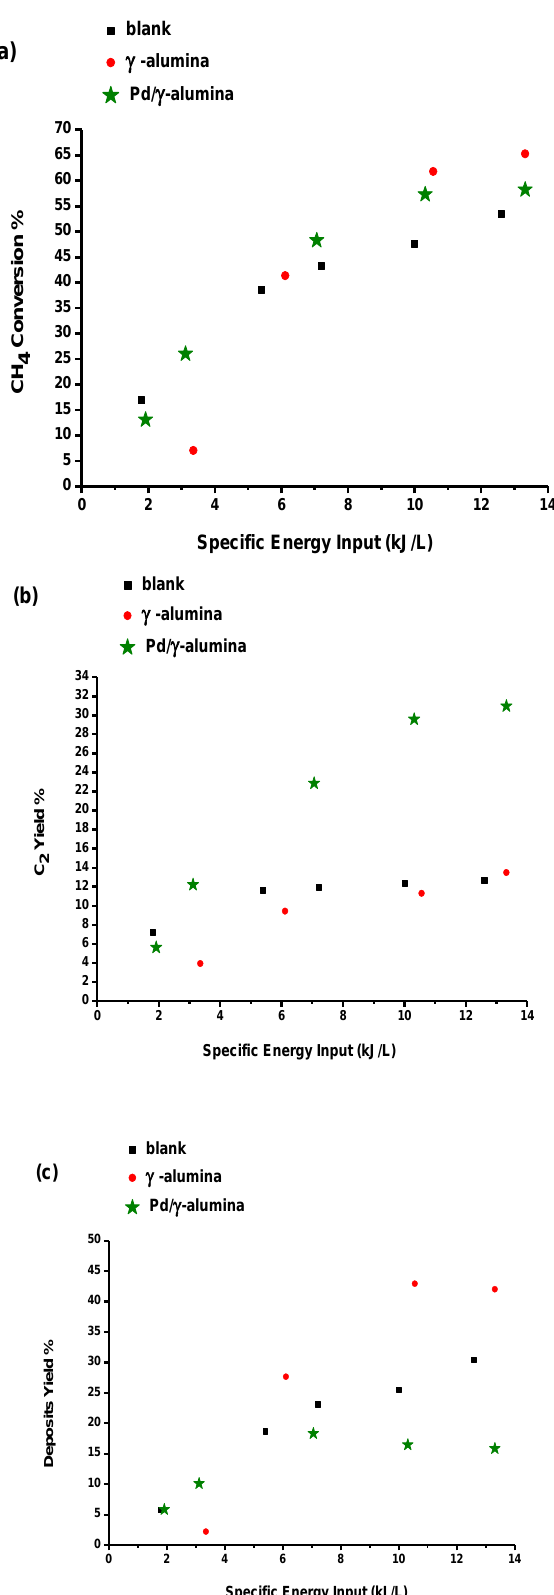
Figure 6. ( a ) Conversion of methane, ( b ) the yield of C 2 compounds and ( c ) the yield of deposits